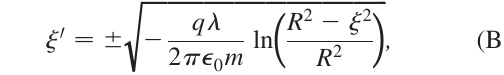
FIG. 18. Diagram of the coordinate system in use for deriving the effects of image charge on a test electron in the